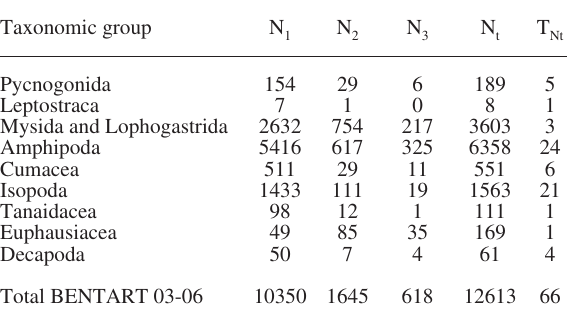
Table 2. – total abundance (number of individuals) and total taxon richness (t , total number of families) of the major suprabenthic nt groups in the 10-50 cm (n ), 55-95 cm (n ), 100-140 cm (n ) and 1 2 3 combined 10-140 cm (n ) near-bottom water layers sampled. t